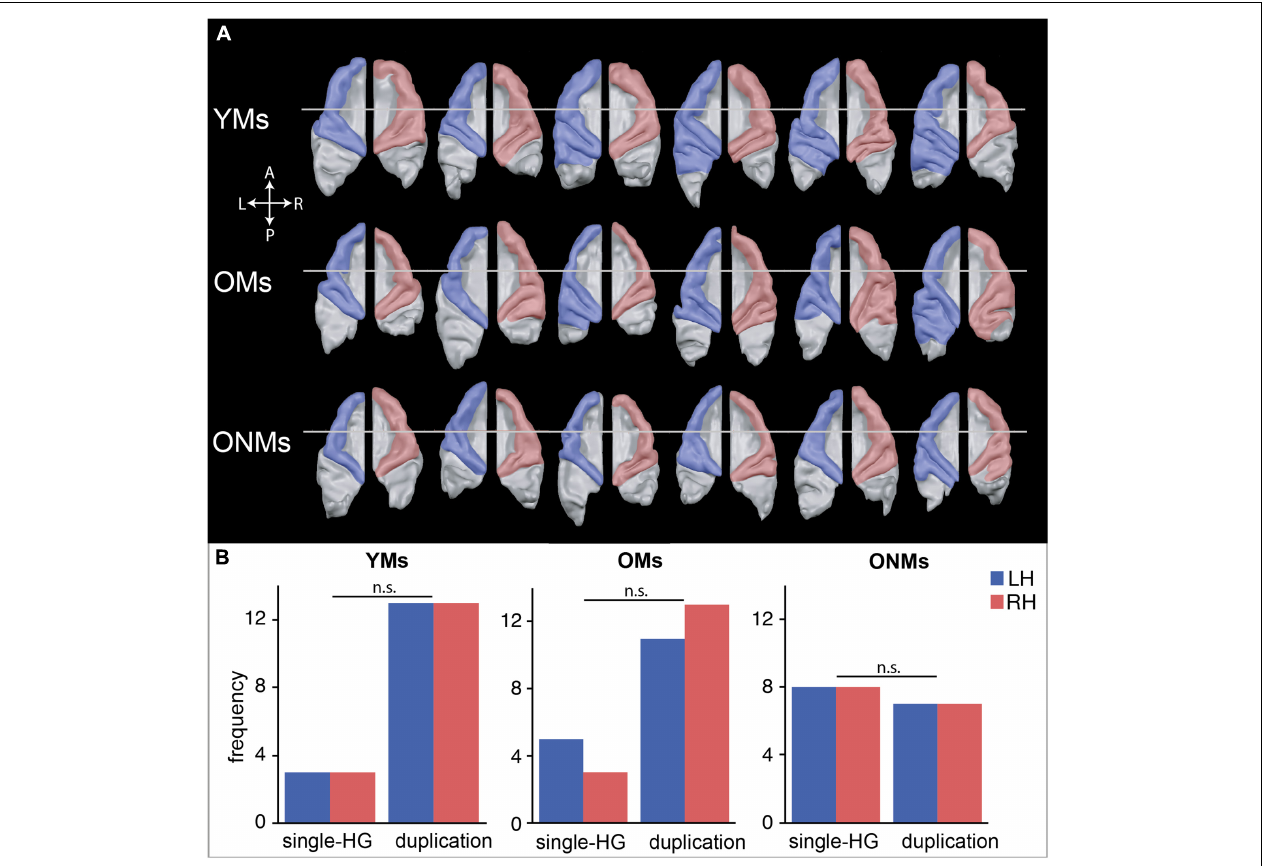
FIGURE 4 | Inter-individual shape differences of the auditory cortex (AC). (A) Subsample of Supplementary Figure 1 demonstrating representative AC surfaces of six exemplary participants, and depicting the characteristic individual shapes of the left (blue) and right (red) AC within each group. Further AC reconstructions of all the subjects are presented in Supplementary Figure 1 . (B) Observed frequencies of the two defined AC types, single and duplicated Heschl’s gyrus (HG), are counted separately per hemisphere. A more detailed definition of HG morphotypes can be found in Supplementary Figure 1B . LH/RH, left hemisphere/right hemisphere; YMs, young musicians; OMs, old musicians; ONMs, old non-musicians; HG, Heschl’s gyrus; n.s., not significant (contrast).